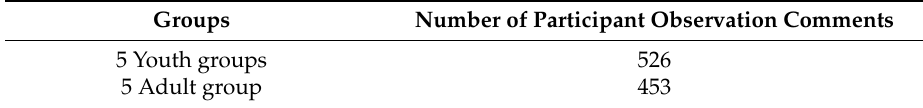
Table 4. The number of participant observation comments